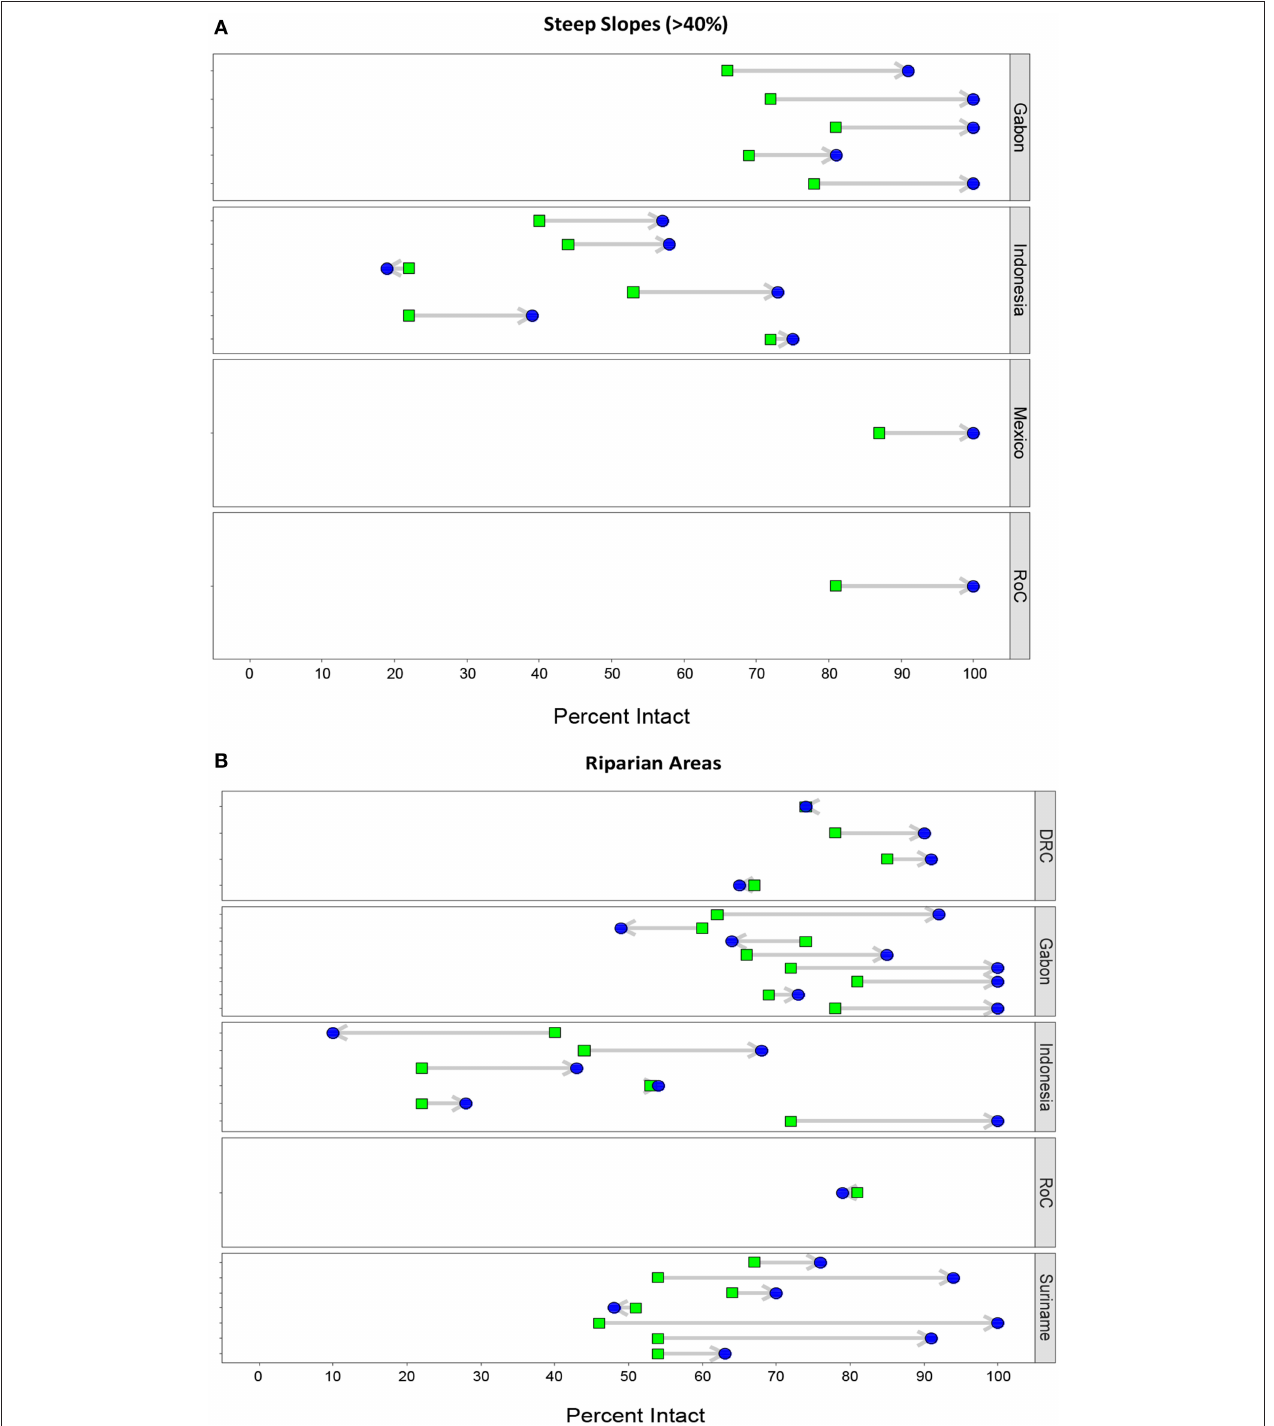
FIGURE 5 | Percentages of 30m pixels in logged blocks left intact by loggers on (A) steep slopes ( > 40%) and (B) < 25m of permanent streams. Green squares show the percent of intact forest in entire logged blocks, blue dots show percent intact on steep slopes and in riparian zones, and gray arrows represent the residual effect